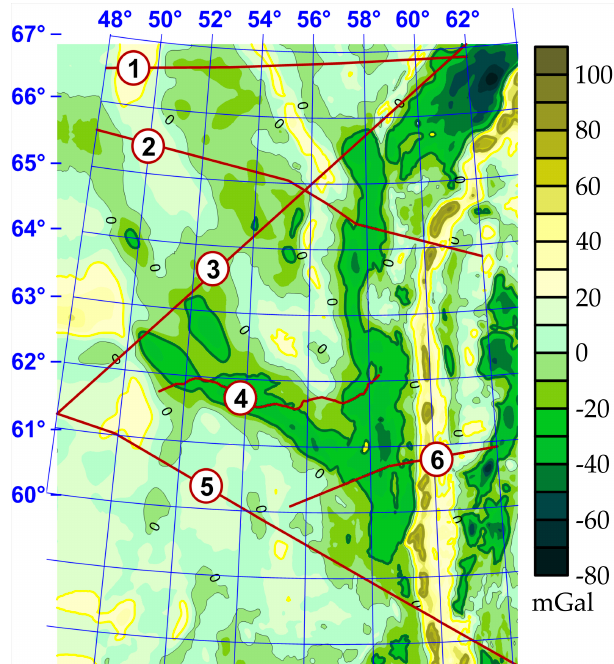
Figure 10. DSS profile scheme with a map of a gravity field anomaly in the Bouguer reduction. Profiles: (1) Agat-2, (2) Quartz, (3) Globus, (4) Syktyvkarskii, (5) Rubin-1, and (6) Krasnoleninskiy.